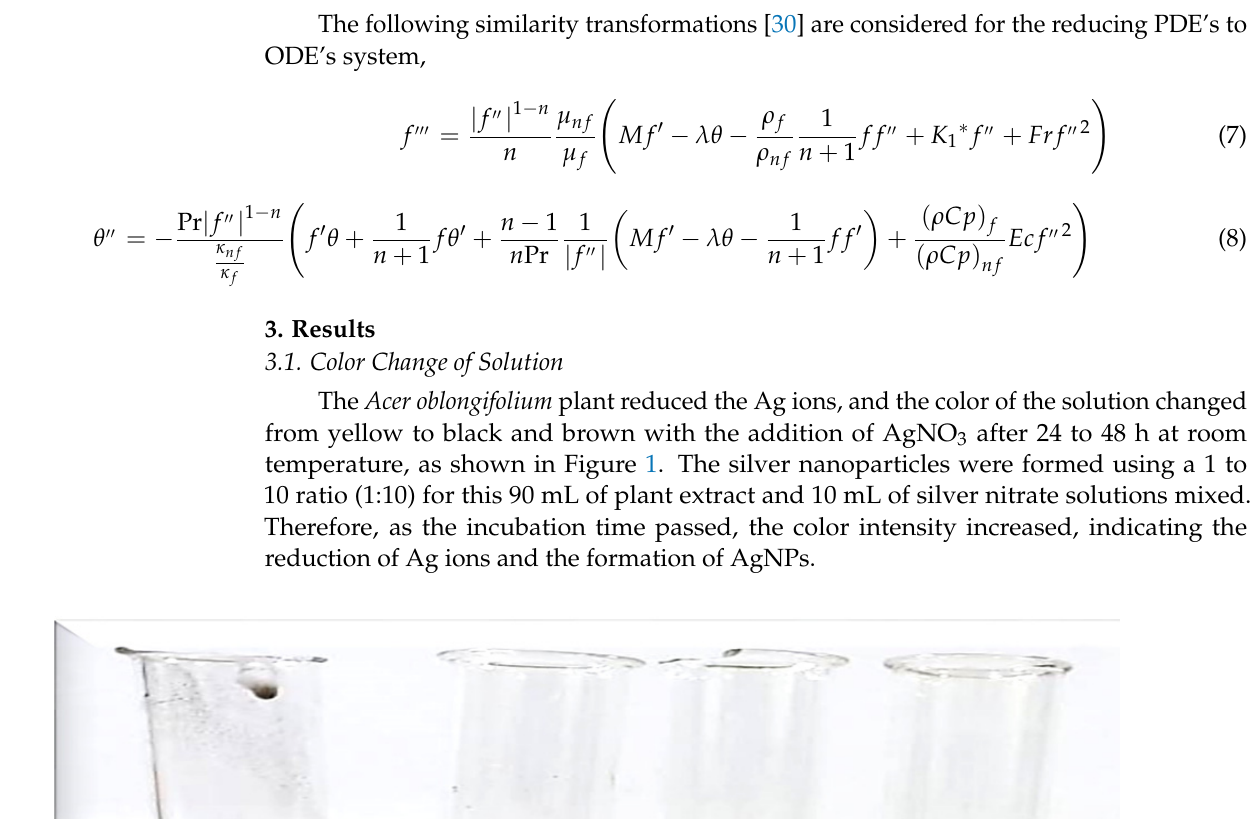
Figure 2. UV visible spectroscopy for silver nanoparticles synthesized using Acer oblongifolium plant extracts. ( a ) Synthesized from 25 mM precursor solution of AgNO 3 , ( b ) synthesized from 1 M solution of AgNO 3 .